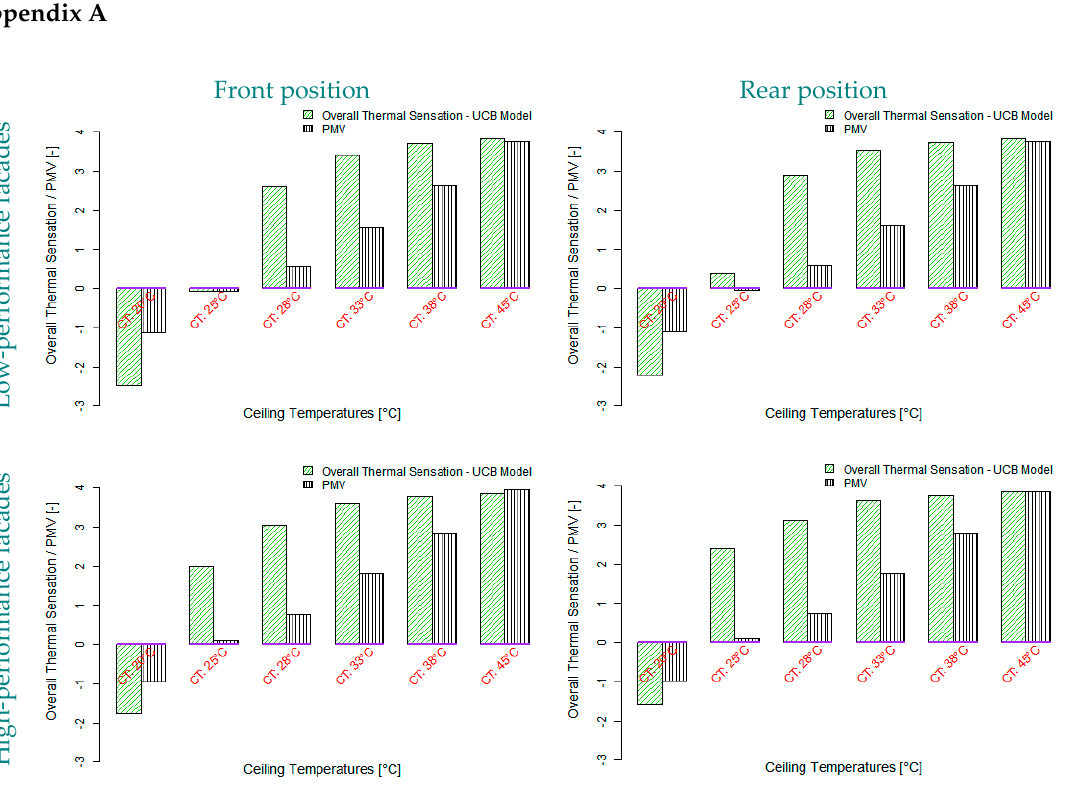
Figure A1. Comparisons between overall thermal sensation values calculated by UCB model-based 16 local thermal sensation values [10] and PMVs calculated using the six environmental and personal parameters [7] in the corner room with one facade.